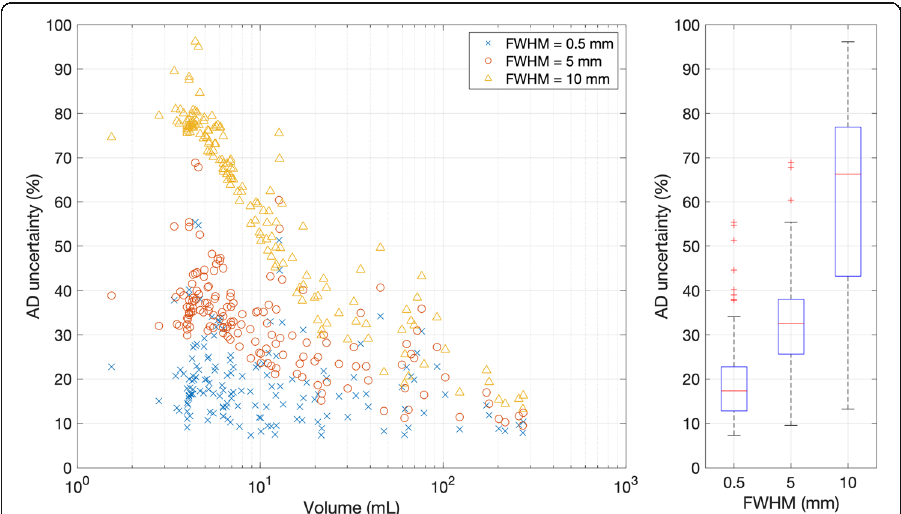
Fig. 6 On the left, absorbed dose uncertainty (%) against volume (mL) calculated for all the lesions, postulating imaging systems with FWHM equal to 0.5, 5 and 10 mm (representative of CT, PET and SPECT systems, respectively). On the right, distributions of absorbed dose uncertainty (%) for each value of the